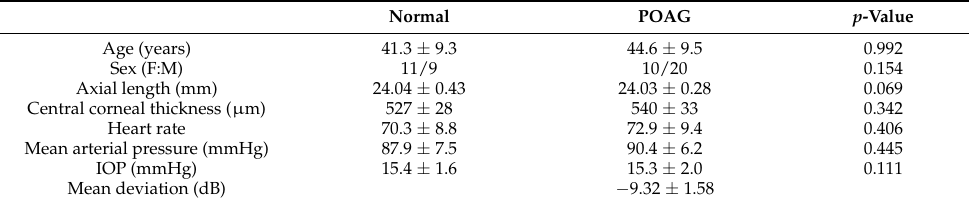
Table 1. Demographic of